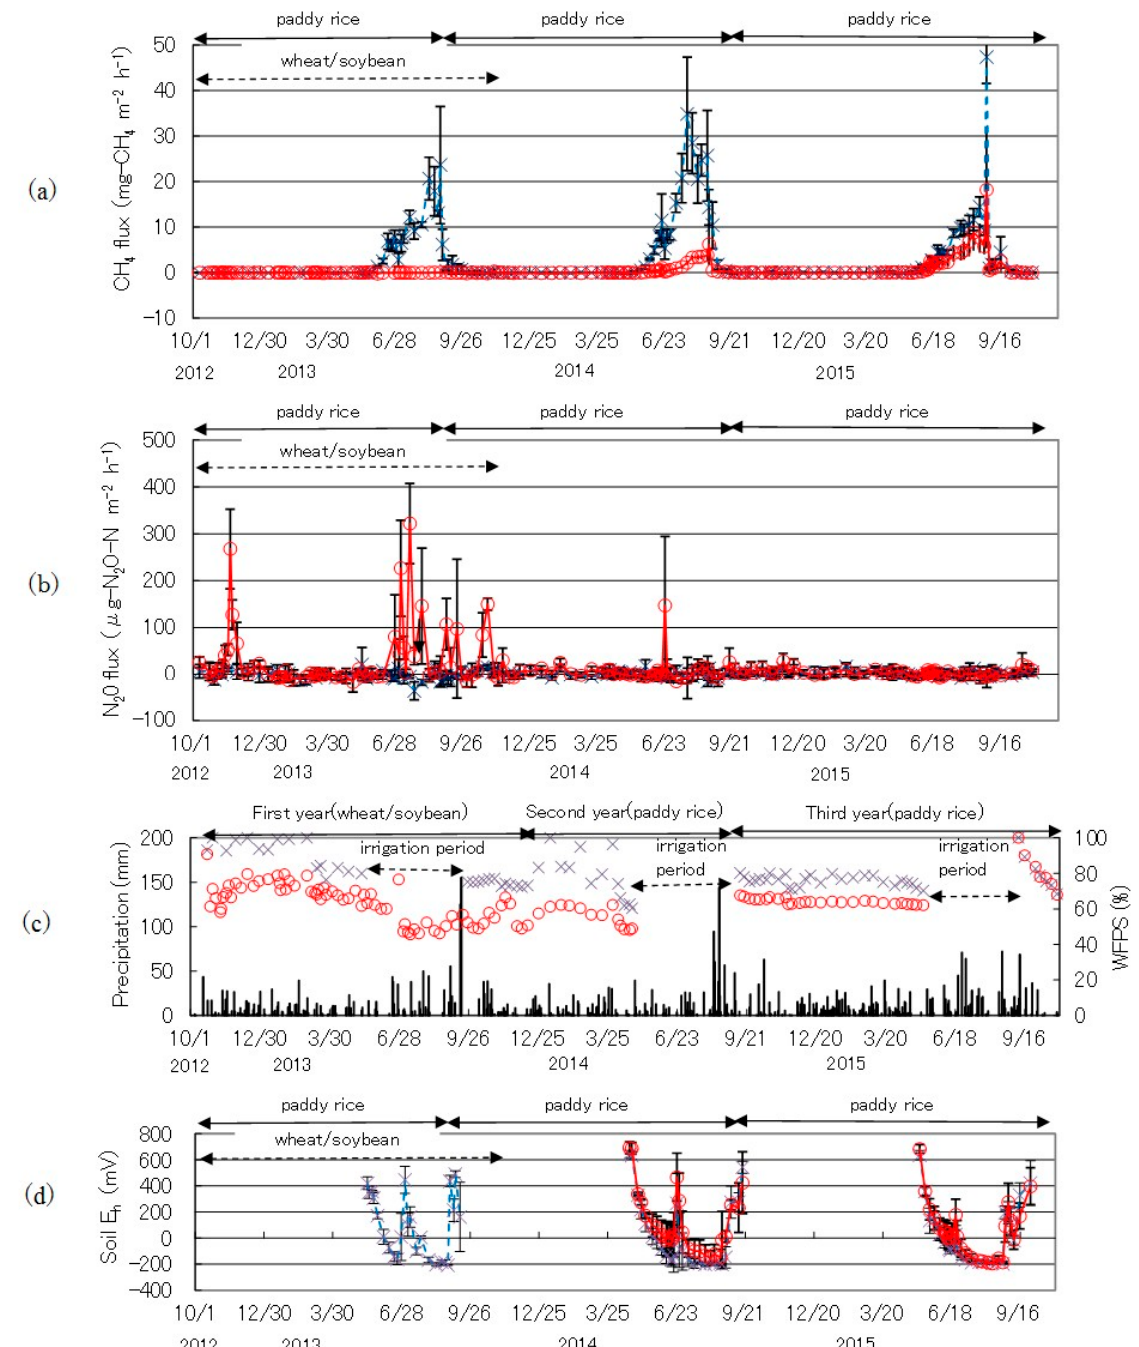
Figure 1. Changes in ( a ) CH 4 flux, ( b ) N 2 O flux, ( c ) Precipitation and WFPS and ( d ) Soil E h , in the three years. × (Blue) :CP, ○ (Red) :PU, (c) ｜ : precipitation. Error bar is shown as standard deviation. The data in PU was derived from the previous report (Hasukawa et al. [43]).